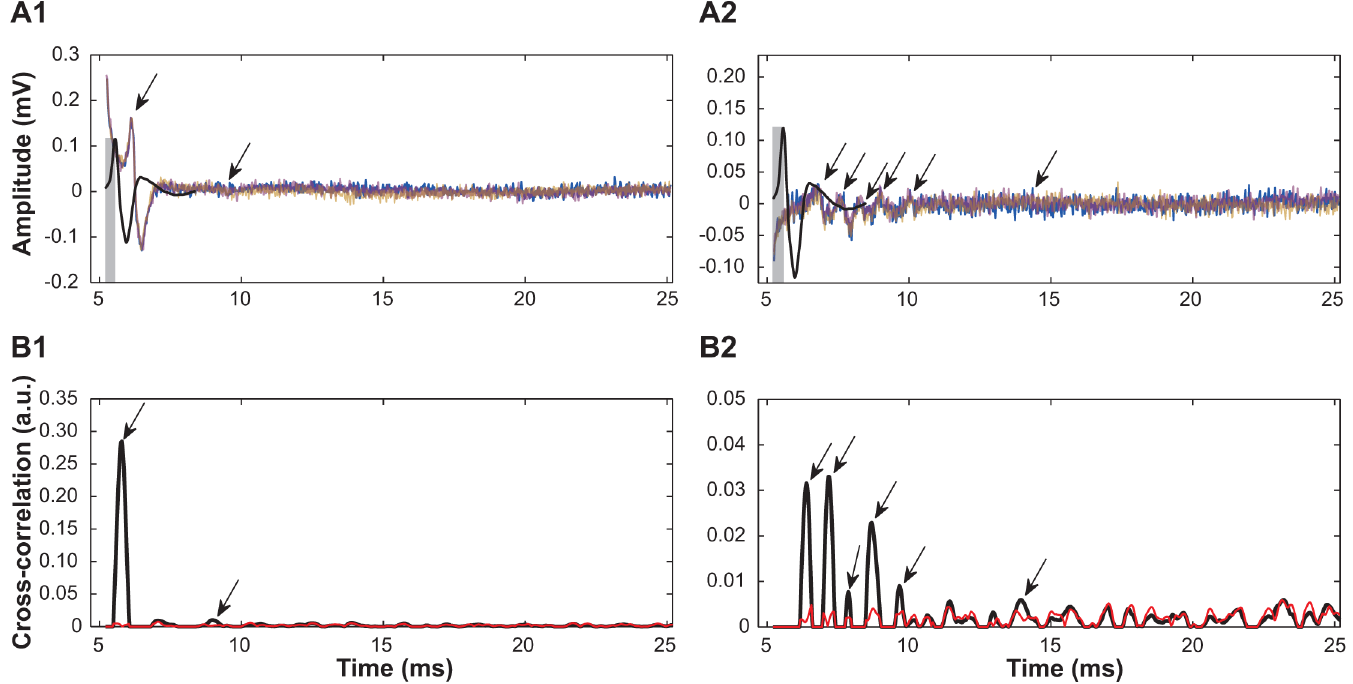
Fig 2. Example of event detection, latency and response magnitude of sural CNAPs derived by WSA. Row A illustrates three N10avRs (repeats are colour coded) to a 0.7 mA stimulus of an intact (A1) and regenerating (A2) nerve from the same animal, with the SN-template (see Fig 1A) superimposed (black). The cross-correlation was calculated for each instant between the SN-template and the N10avR, by sliding the SN-template trace across each N10avR. Row B illustrates the mean (black) and one standard deviation (red) of the cross-correlations calculated between SN-template and the three repeated N10avRs for an intact (B1) and a regenerating (B2) nerve of the same animal. An event was considered detected when the peaks of the mean of 3 cross-correlations was (cid:4) a detection threshold level (see Fig 3 for calculation of the detection threshold level). The latency for each event was given by the time of each respective mean cross-correlation peak (arrows row B) plus the 0.35 ms time lag between the onset and peak of SN-template (grey bars indicate latency correction, row A). The magnitude of each event was quantified as the peak of the mean cross-correlation for each event detected (arrows, B1 and B2), and is proportional to the energy of the event measured in arbitrary units (amplitude correction not shown). Total magnitude of each N10avR was calculated as the sum of the magnitudes of all events in N10avR (sum of all peaks indicated by arrows in B1 and B2).